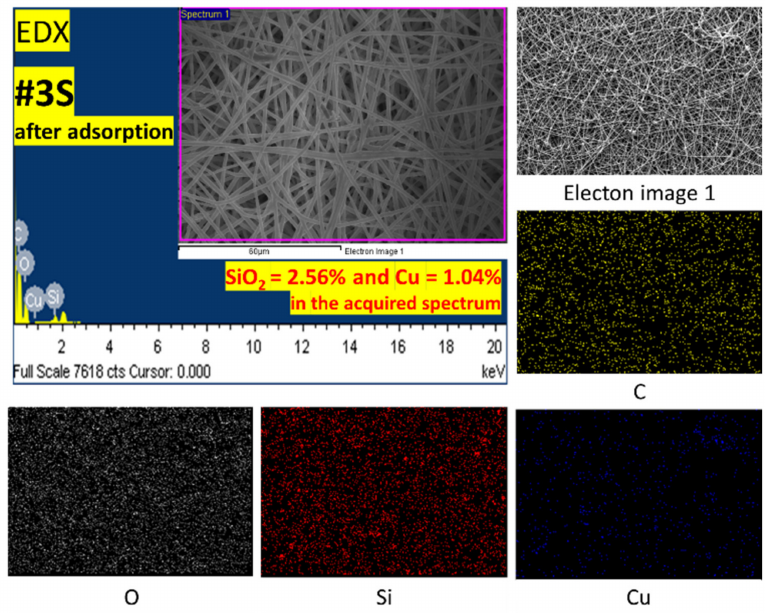
Figure 9. The EDX results of #3S after adsorption of Cu 2+ ions with elemental mapping of Carbon (C), Oxygen (O), Silica (Si), and Copper